Question: Which visualization type does this figure use?
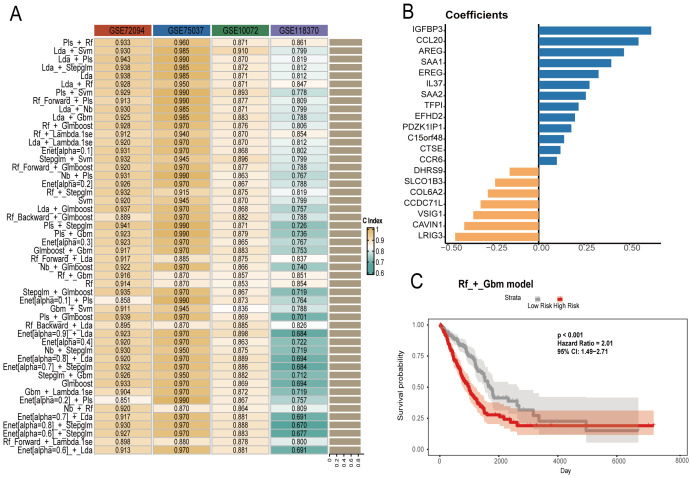
Answer: heatmap